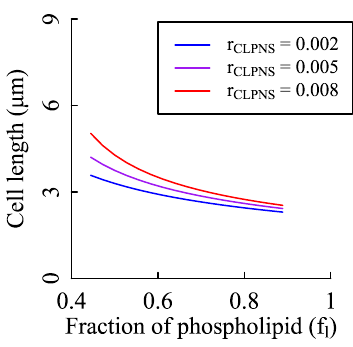
Figure A9. Effects of the fraction of phospholipid in membranes on cell size. According to the Equation (20), the fraction of phospholipid does have influence on the cell length. To test the impact strength, we fixed the cardiolipin synthesis rate and changed f l . The values of n 0 , K M , and V max were the same as those of Figure 2A. We set r CLPNS to three values with the unit of mmol/(gDW ·